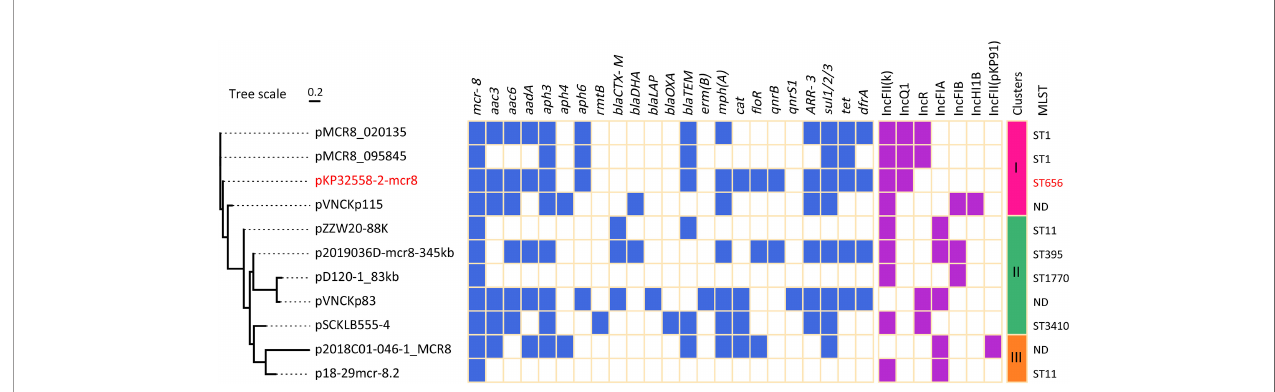
FIGURE 2 | Resistance genes and replicons of mcr-8.2 -carrying plasmids. The pKP32558-2-mcr8 (CP CP076032) was derived from K. pneumoniae KP32558 of this study. The genomic sequences of plasmids pMCR8_020135 (CP037964), pMCR8_095845 (CP031883), pVNCKp115 (LC549807), pZZW20-88K (CP058962), p2019036D-mcr8-345kb (CP047337), pD120-1_83kb (CP034679), pVNCKp83 (LC549808), pSCKLB555-4 (CP043936), p2018C01-046-1_MCR8 (CP044369) and p18-29mcr-8.2 (MK262711) were obtained from NCBI database.